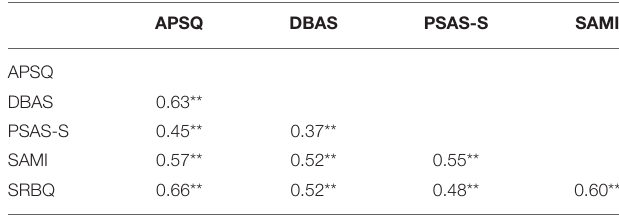
Pearson’s correlation coefficient was used as correlation statistics. APSQ, anxiety and preoccupation about sleep questionnaire; PSAS-C, pre-sleep arousal